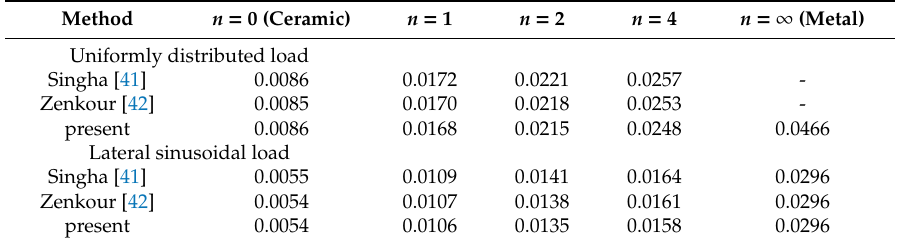
and the transverse sinusoidal load q sin ( π x / a ) sin ( π y / b )